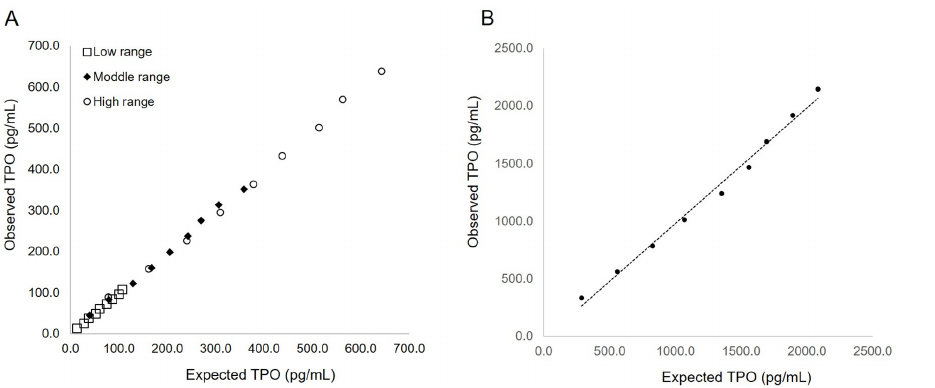
All dilution linearity studies using specimens with concentrations ranging from 13.1 to 684.9 pg/mL showed correlation coefficients ranging from 0.998 to 0.999 (Figure 3A). The recovery rate of the diluted samples ranged from 87.3% to 106.3%. No high-dose hook effect was observed in the testing conditions up to approximately 2300 pg/mL (Figure 3B). Under these conditions, the dilution linearity showed a correlation coefficient of 0.996 and recovery rates in the range of 86.0% to 109.0%.